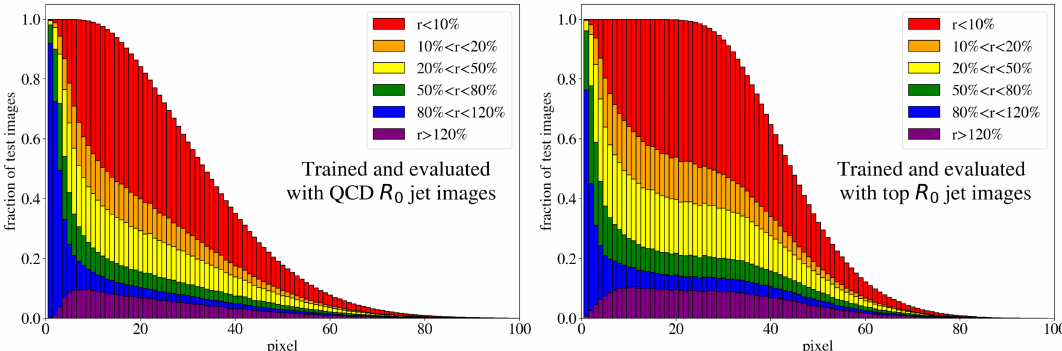
Figure 10 . Same as figure 4 but using KMSE as the loss function during training. No smearing kernel is applied for the data shown during testing.